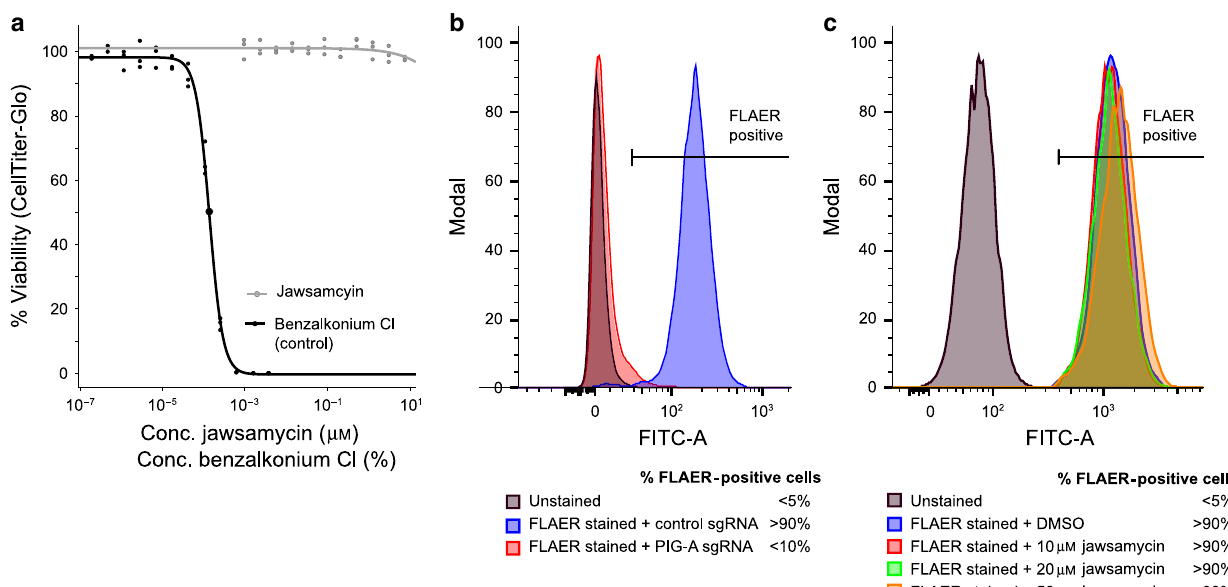
Fig. 3 Jawsamycin does not display activity against the human SPT14 homolog PIG - A . a Cytotoxicity assessment by dose-response testing of jawsamycin and the control compound benzalkonium chloride against human HCT116 cells. b Genetic validation of the FLAER assay: genetic editing of the PIG-A gene leads to loss of extracellular concentration of GPI-anchored proteins in HCT116 cells as assessed by staining with the fl uorescently labeled GPI- binding compound aerolysin (FLAER) and fl ow-cytometry analysis. c Incubation of HCT116 cells with different doses of jawsamycin has no apparent effect on GPI-anchored proteins as observed by FLAER staining and fl ow-cytometry analysis. For each histogram in panel a and b , 10,000 events were recorded and peak heights normalized. Unstained and untreated control samples were used to set the gating strategy (gating strategy images and additional data are provided in the Source Data fi